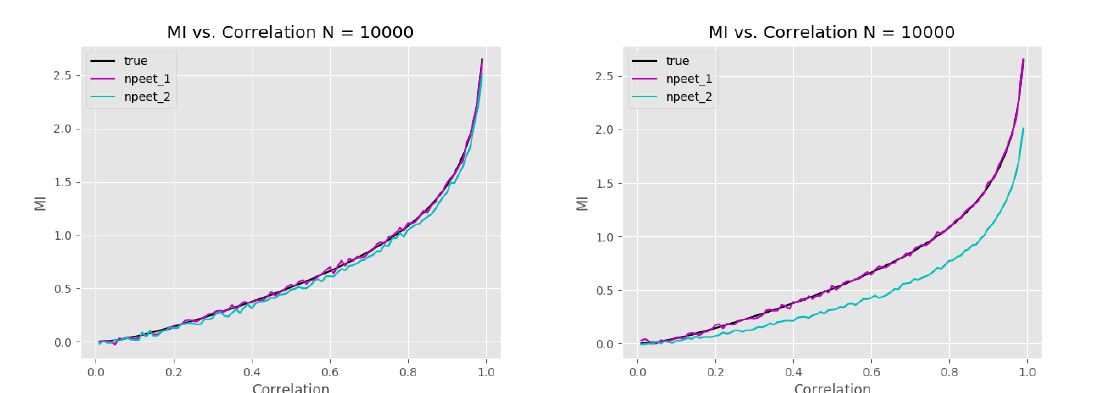
Figure 3. Comparison of mutual information estimates KSG for a multivariate normal distribution with equal correlation coefficients ρ ij before (npeet_1) and after (npeet_2) a linear transformation of one variable by a factor of 10. The second plot compares the KSG estimators after four variables are multiplied by a factor of 10.